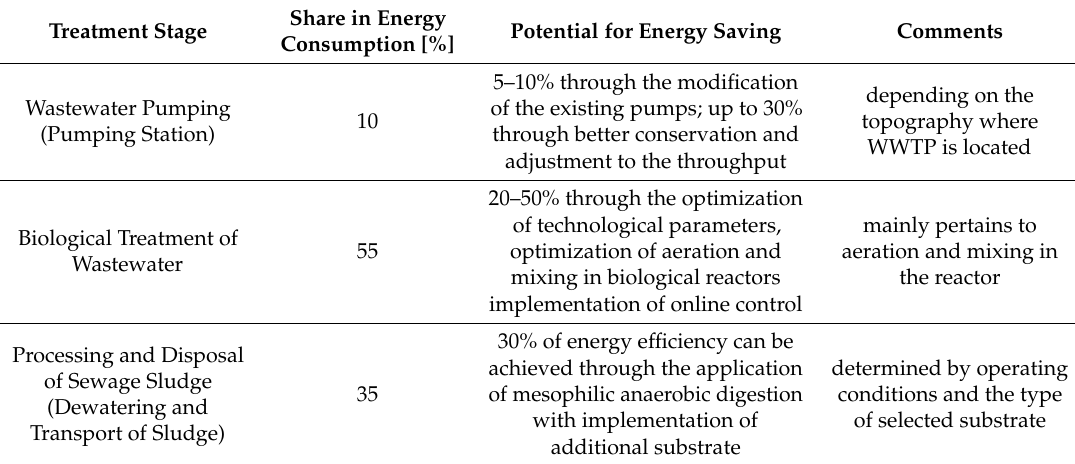
Table 1. Distribution of energy consumption and potential for energy saving in a selected WWTP with an activated sludge system